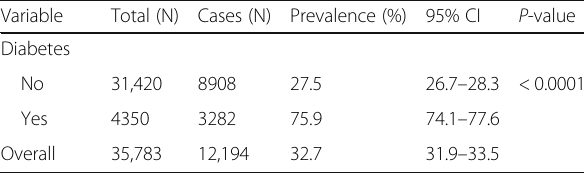
Table 1 Type 2 diabetes screening prevalence (%)